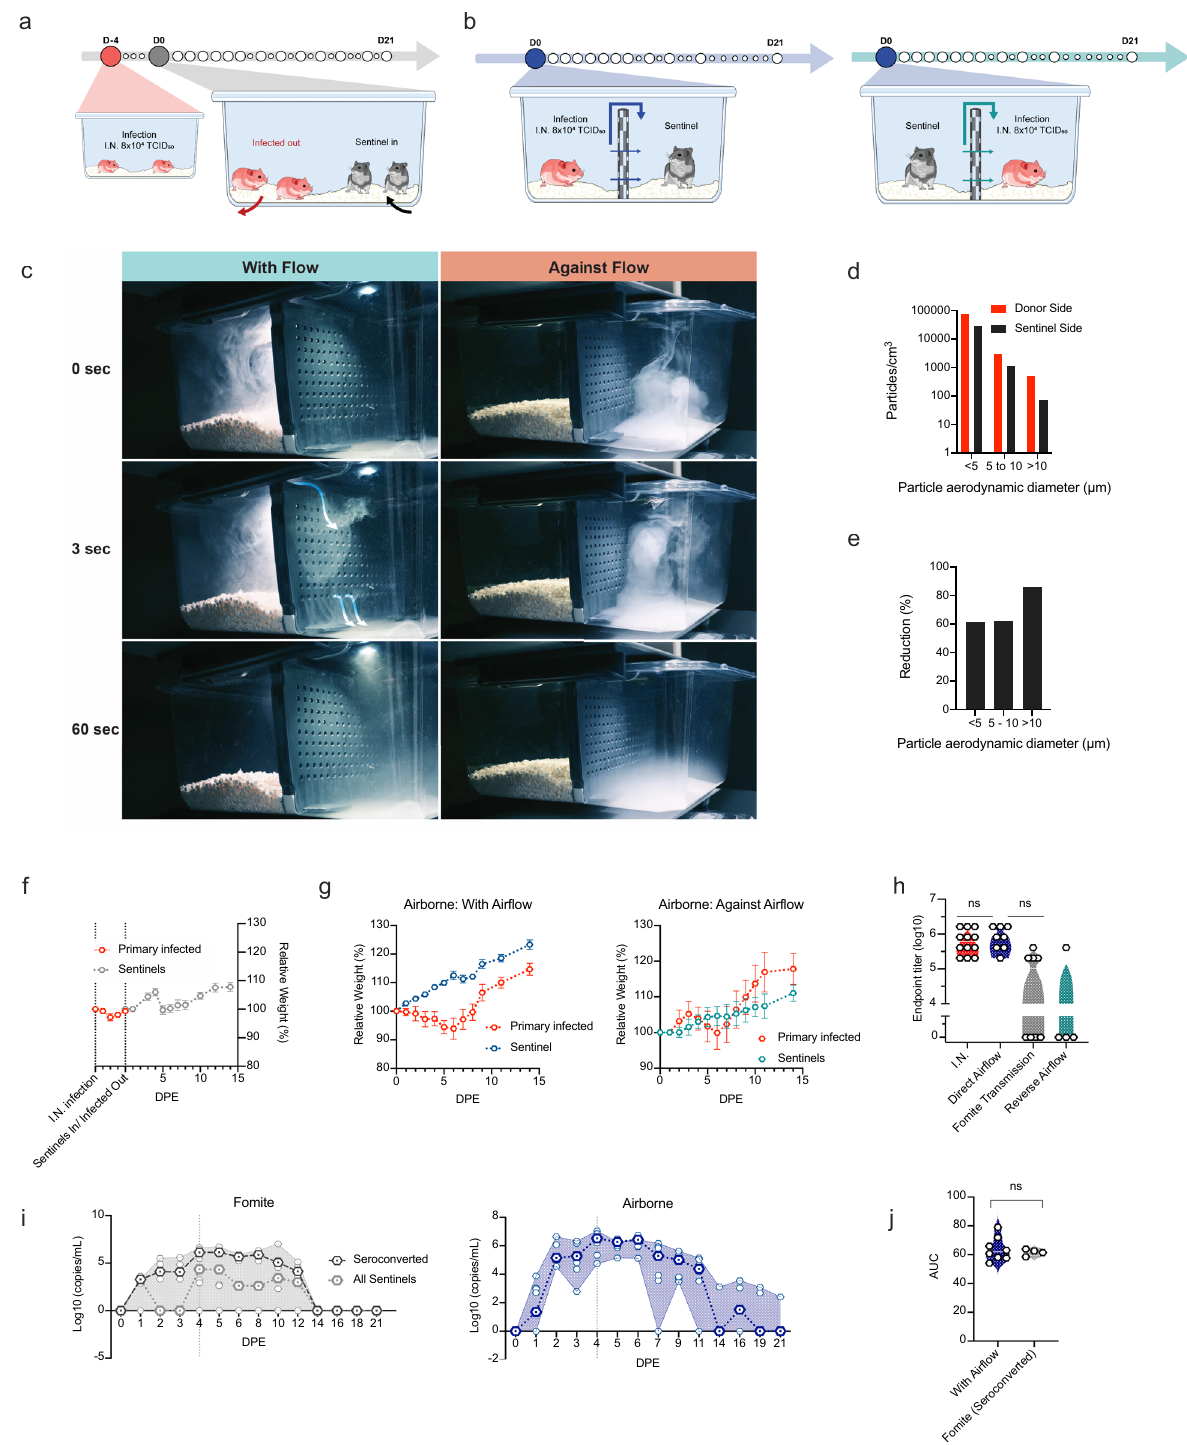
Fig. 6 Fomite and airborne transmission in the Syrian hamster. a Experimental layout for fomite and b airborne exposure experiments in hamsters. I.N. = intranasal. c Pictures of smoke test to demonstrate unidirectional air fl ow in the transmission cage. d Aerodynamic particle size distribution on either side of the transmission cage. e Reduction of particles by the divider. f , g Relative weight loss in hamsters after SARS-CoV-2 transmission via fomite and airborne routes. DPE = days post exposure. Lines represent mean ± SEM. h Violin plot with individuals and median of endpoint IgG antibody titers against SARS- CoV-2 spike ectodomain by ELISA in serum of hamsters infected through airborne and fomite transmission route. ELISAs were done once. i Respiratory shedding pro fi le of hamsters exposed through fomite and airborne transmission routes, individuals, median and 95% CI are shown. j Cumulative (area under the curve (AUC) analysis) of respiratory shedding from animals which seroconverted after airborne and fomite transmission. Violin plots with individuals and median are depicted. Statistical signi fi cance was measured by Kruskal – Wallis test, N = 8 per group. * P < 0.05, ** P < 0.001, *** P < 0.0001, **** P < 0.0001. NS, not signi fi cant. Source data are provided as a Source Data fi